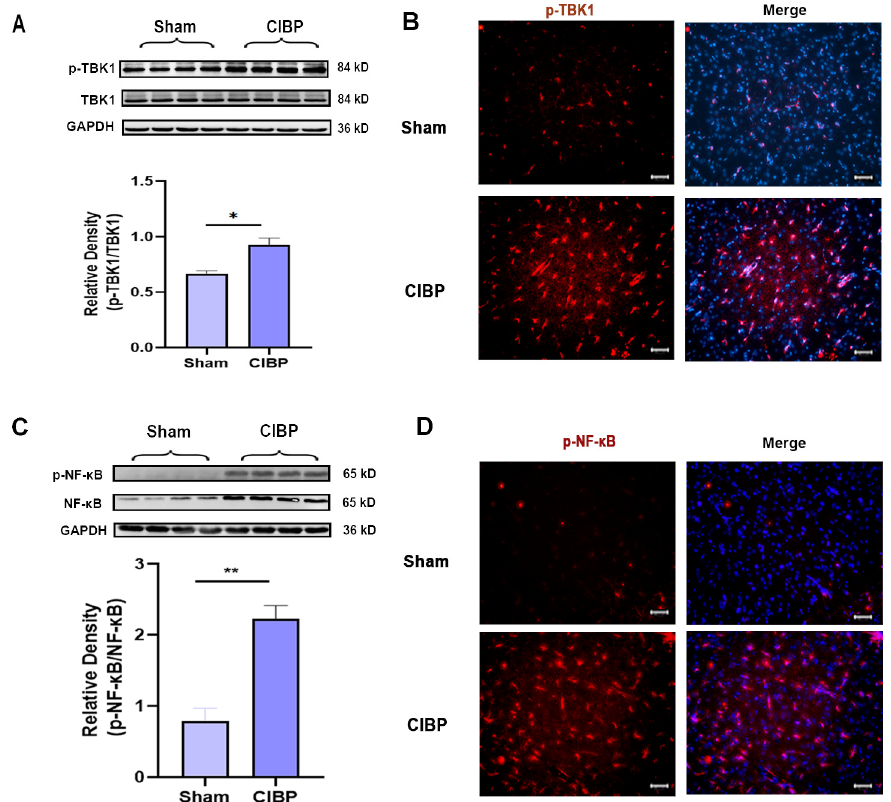
Figure 2. The downstream factors of STING were significantly increased in the mPFC after CIBP. ( A , B ) Western blot ( A ) and immunofluorescence ( B ) showed that p-TBK1 increased in the mPFC after CIBP. ( C , D ) Western blot ( C ) and immunofluorescence ( D ) showed that p-NF- κ B increased in the mPFC after CIBP. The nuclear was labeled with DAPI (blue). GAPDH was detected as an internal control. Data are expressed as mean ± S.E.M., n = 4, * p < 0.05, ** p < 0.01, CIBP vs. sham. Scale bar = 50 µ m. Full pictures of the Western blots are presented in Supplementary